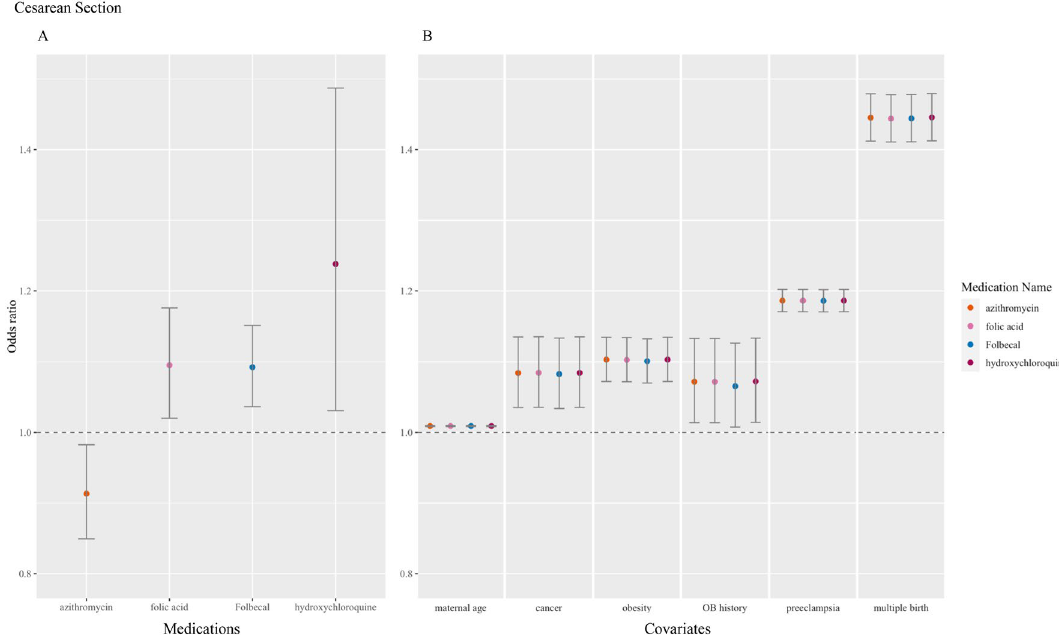
Figure 2. Medications and covariates significantly associated with cesarean section, odds ratio (95% confidence intervals). Plotted by ( A ) significant medications and ( B ) significant covariates.